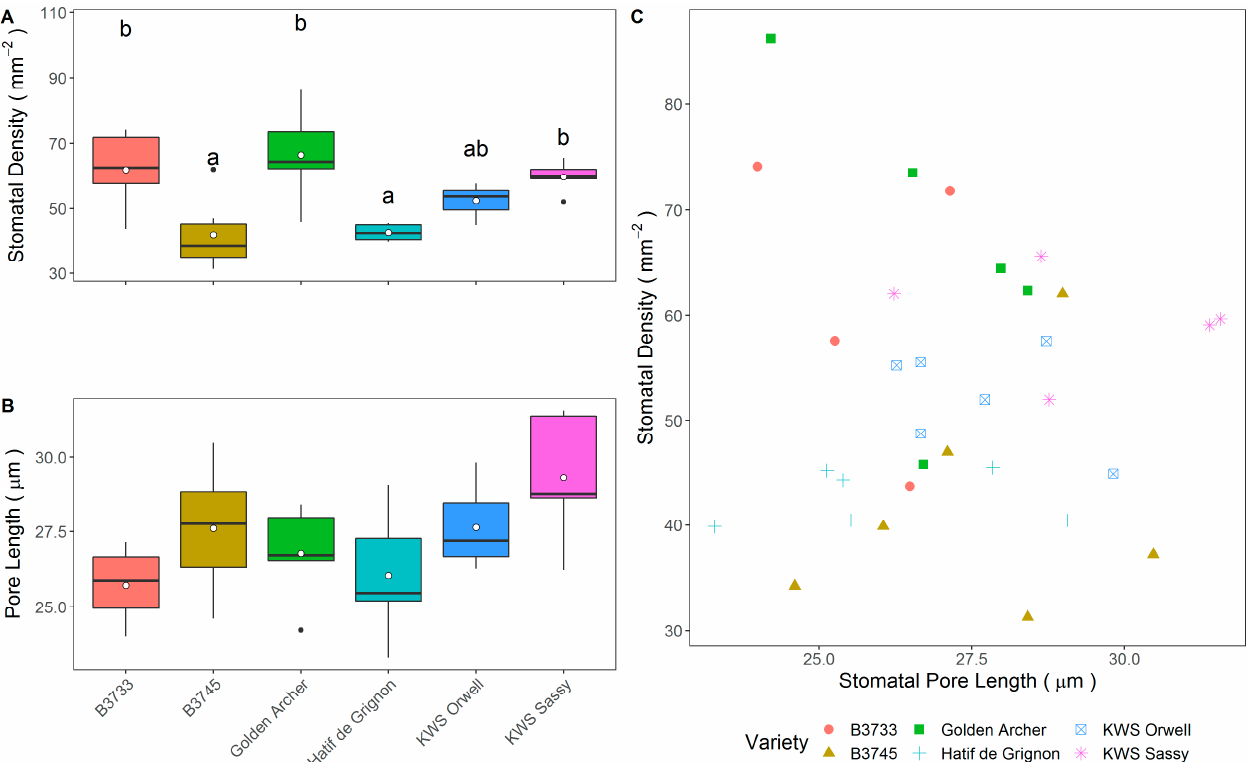
Figure 3. Stomatal anatomy of 6 select barley cultivars: the wild barleys B3733 and B3745, the landraces Golden Archer and Hatif de Grignon and the elite cultivars KWS Orwell and KWS Sassy acquired at the same time and from the same plants as gas exchange data. ( A ) Stomatal density. ( B ) Stomatal Pore length. ( C ) Comparison of stomatal pore length to stomatal density. No correlation was found between the two even if the effect of cultivar was considered. Means shown as white dots in box and whisker plots in panels A and B, N = 5–6. Identical letters denote no significant differences between means based on Tukey’s test of model outputs at p =